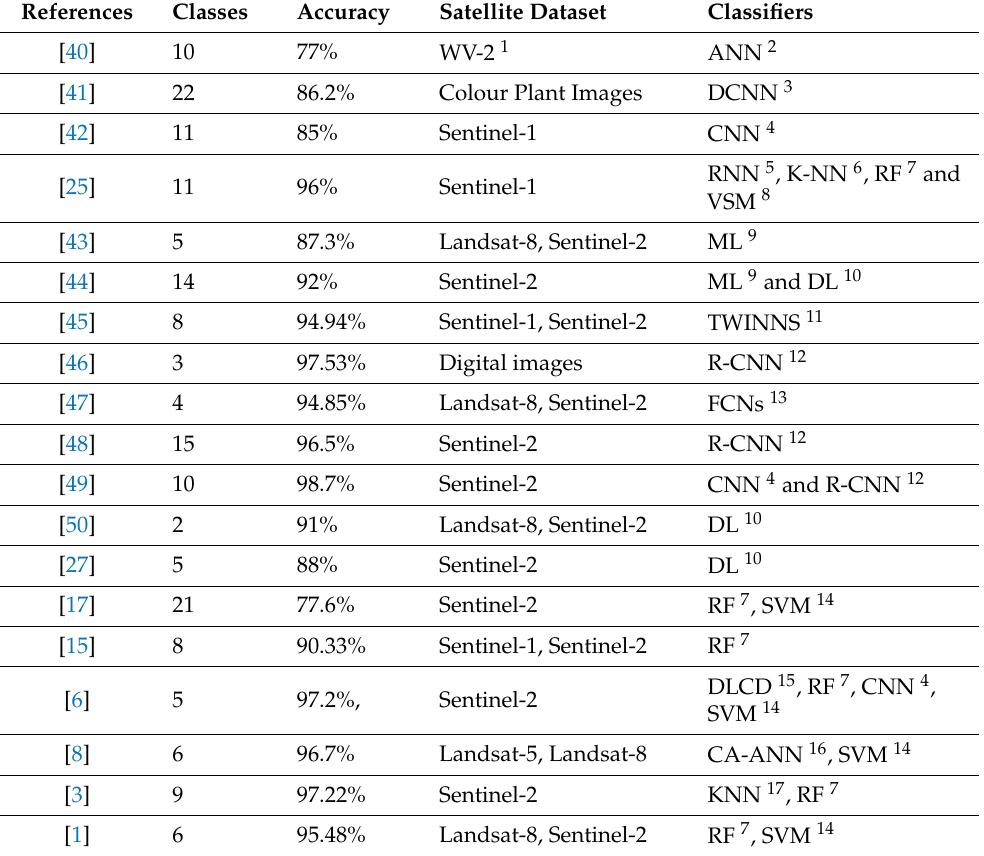
Table 1. A brief summary of different classification